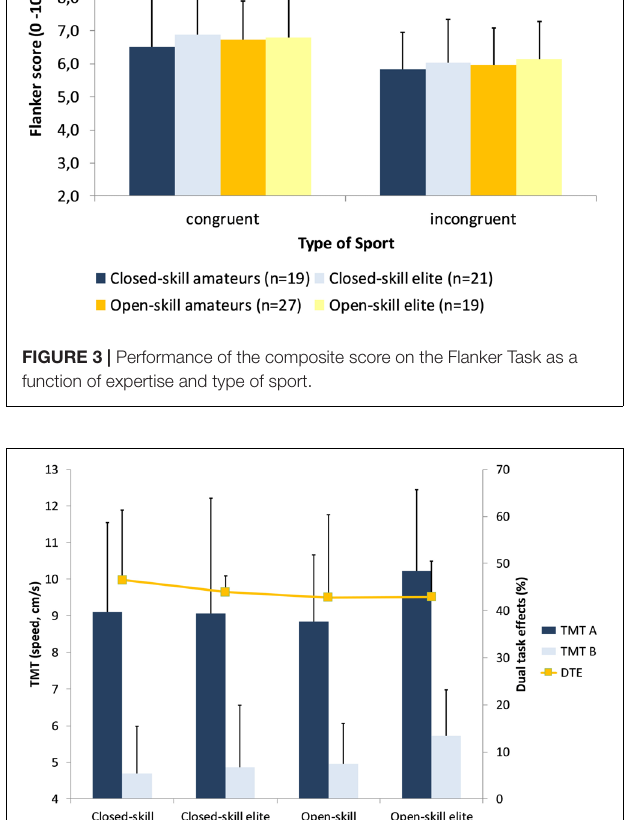
difficulty, [ F (2,158) = 20.4, p < 0.001, η 2